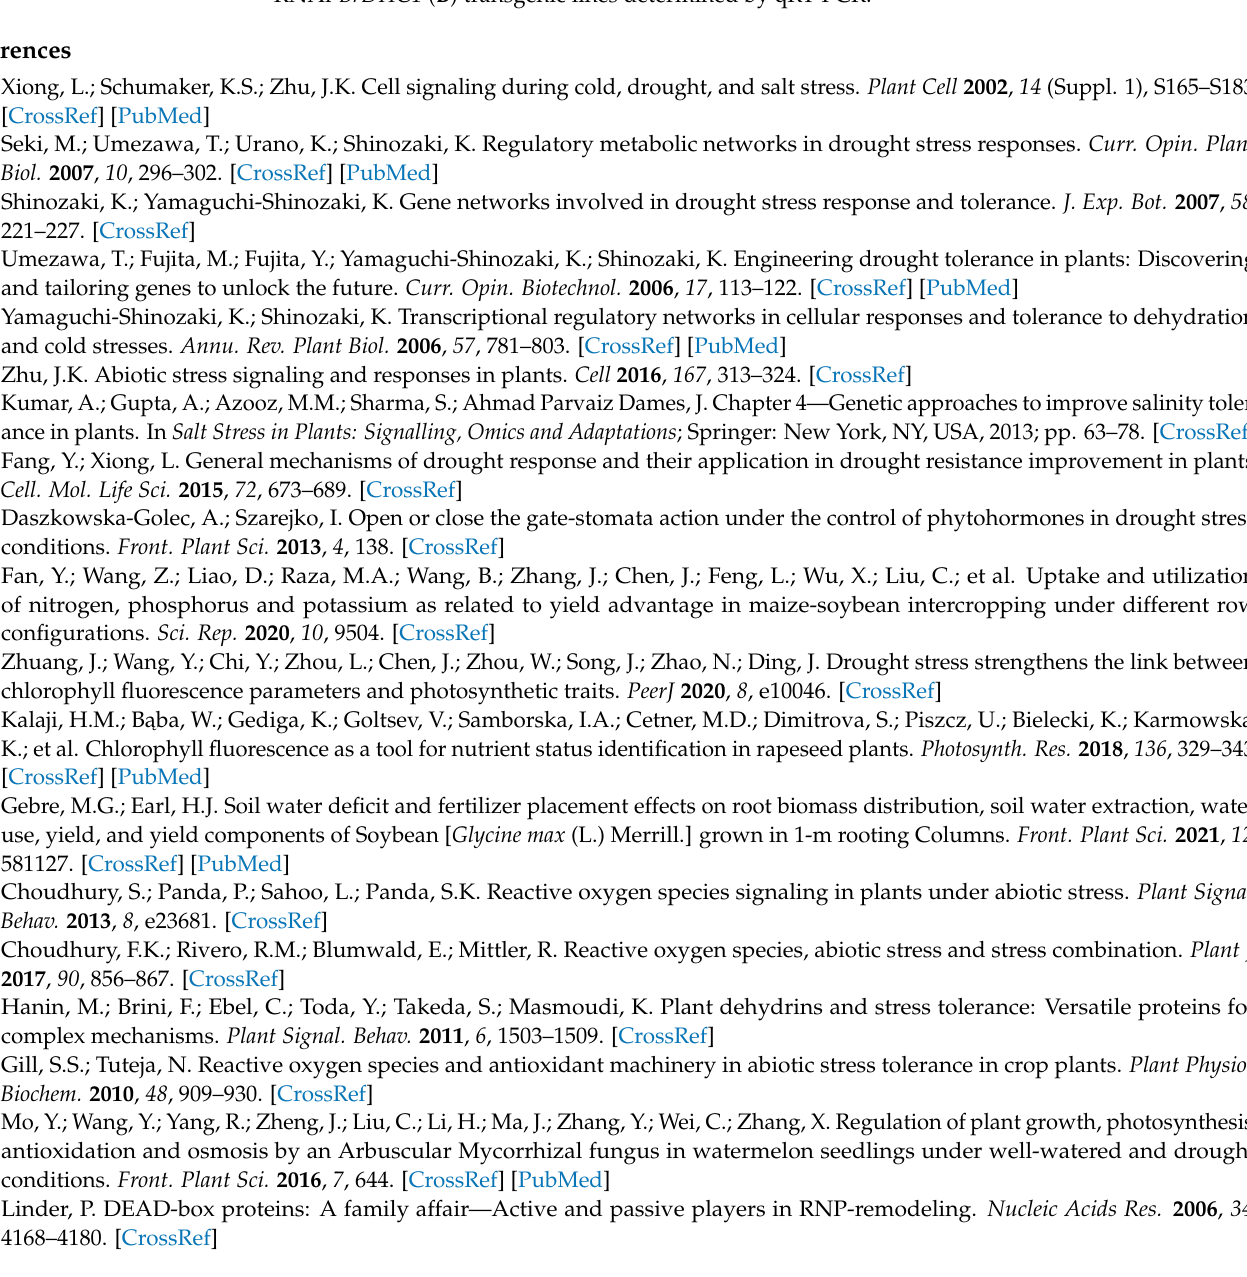
Figure A1. Relative expression level confirmation of the BrDHC1 gene in OE- BrDHC1 ( A ) and RNAi- BrDHC1 ( B ) transgenic lines determined by qRT-PCR.